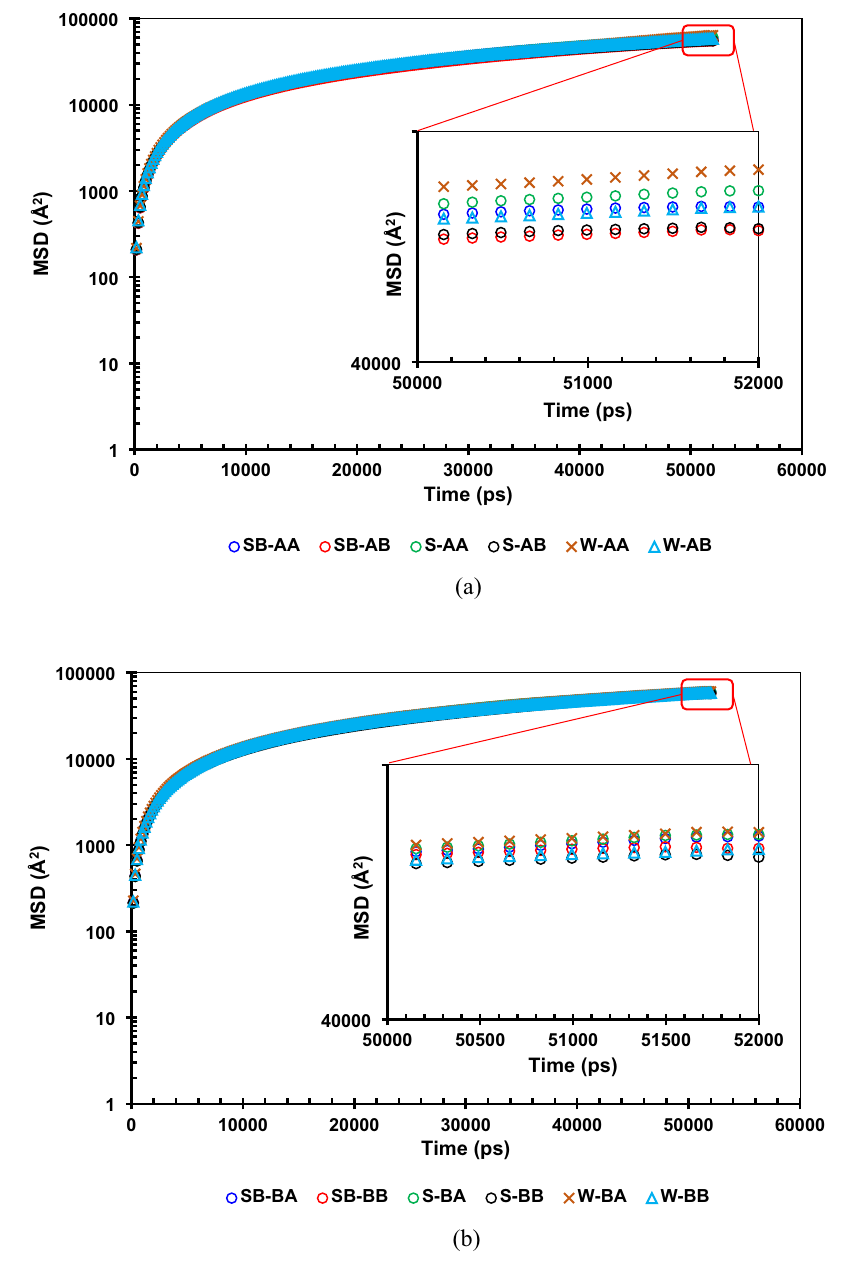
Figure 14. MSD of water for systems containing ( a ) C 40 H 30 O 2 and ( b ) C 44 H 40 N 2